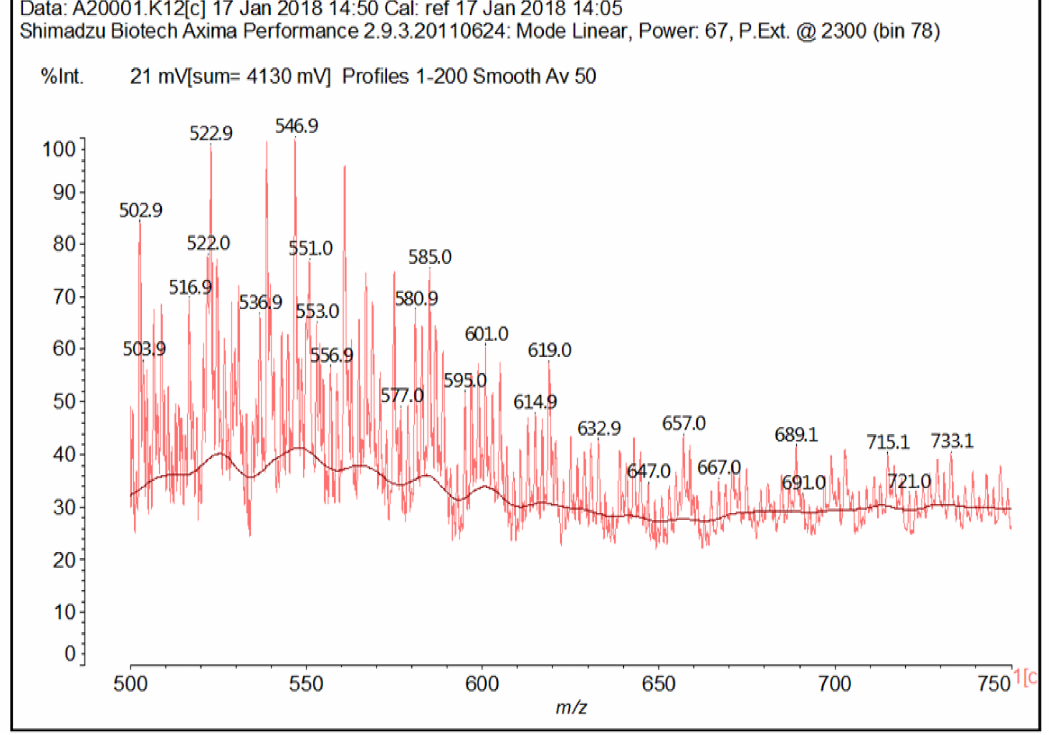
Figure 10. MALDI ToF spectrum of the A2 NIPU resin. Detail of the 500–7500 Da range.